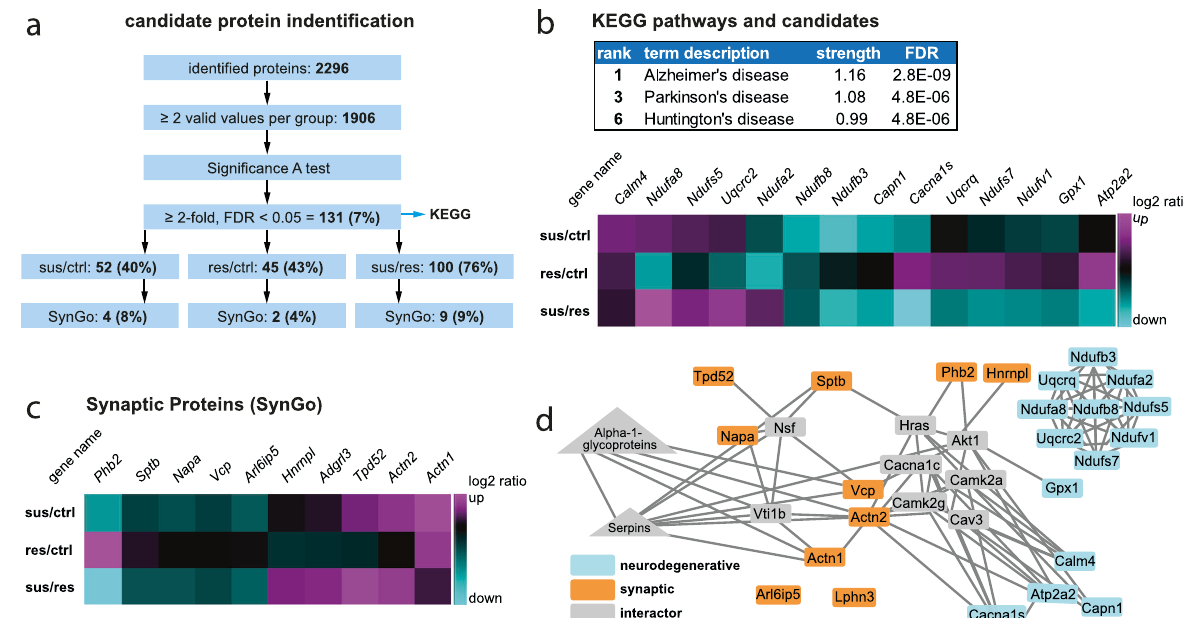
Fig. 5 Proteins linked to neurodegeneration and synapses are regulated long-term in CSF after CSDS. a Work fl ow for identi fi cation of regulated proteins from the CSF sample set (ctrl n = 17, resilient n = 11, susceptible n = 10 mice). b Signi fi cant KEGG pathway results for neurodegenerative disorders and their regulated protein groups (gene names shown). c Regulated synaptic protein groups by SynGo database annotation (gene names shown). d Interaction network of the regulated candidates from the neurodegenerative and synaptic